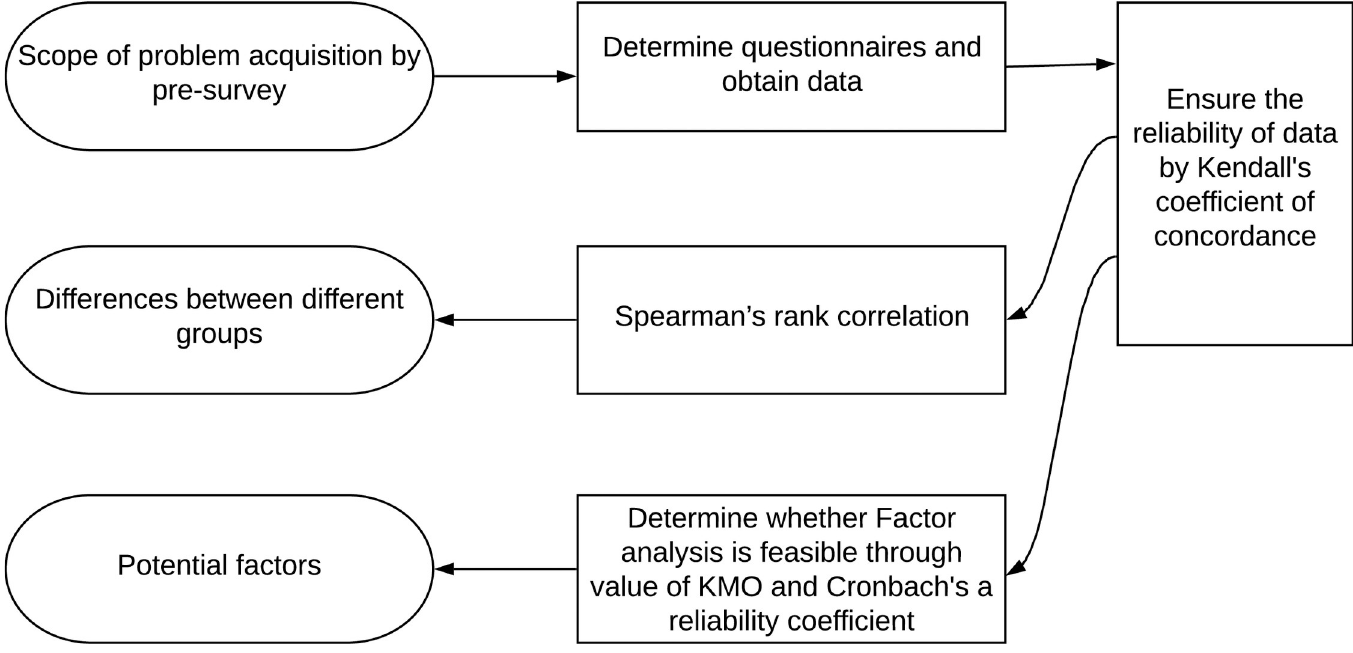
Fig 2. Data analysis flow